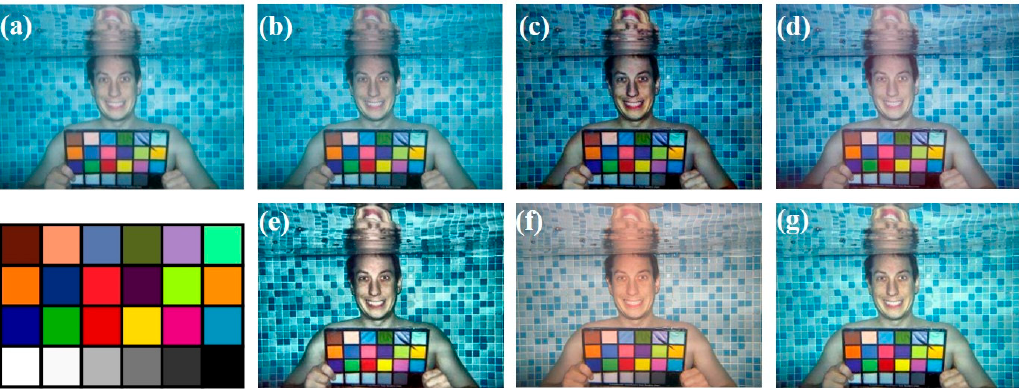
Figure 2. Color restoration: ( a ) Initial image, ( b ) He [9], ( c ) Galdran [32], ( d ) Galdran [6], ( e ) Ancuti [11], ( f ) Ancuti [4], ( g ) our result.